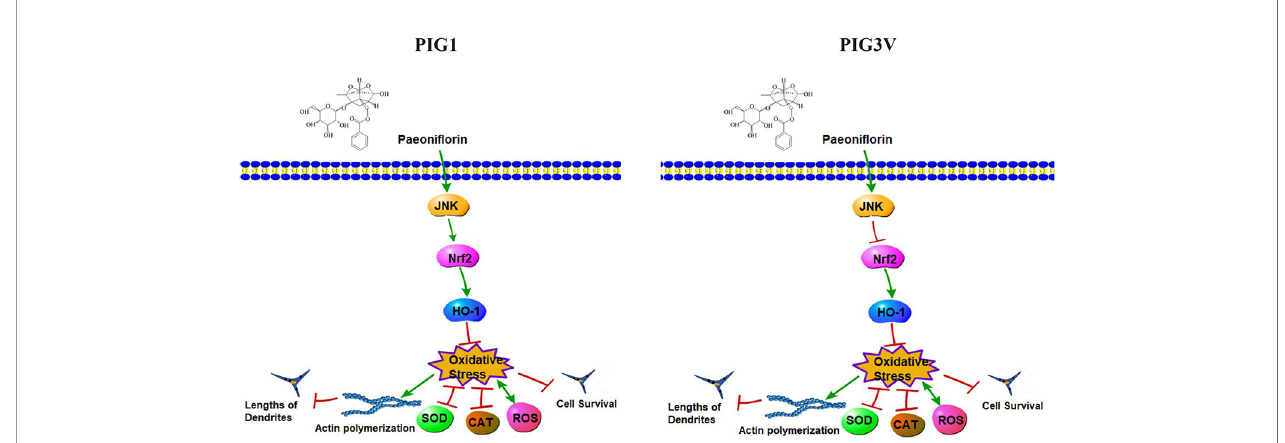
FIGURE 7 | The signaling pathway network by which PF resists H 2 O 2 -induced oxidative stress in melanocytes. PF may depended on the JNK/Nrf2/HO-1 pathway to reduce oxidative damage which was re fl ected in suppressing reactive oxygen species (ROS) accumulation and enhancing the productions of superoxide dismutase (SOD) and antioxidant enzymes catalase (CAT), therefore, PF inhibited cell apoptosis and promoted cell proliferation., Moreover, PF promoted dendrite extension probably by inhibiting the actin polymerization in stressed cells. In addition, JNK increased the Nrf2 expression in PF-pretreated PIG1, but inhibited the expression of Nrf2 in PF-pretreated PIG3V under oxidative stress. Pathway Builder Tool 2.0 was used to draw this